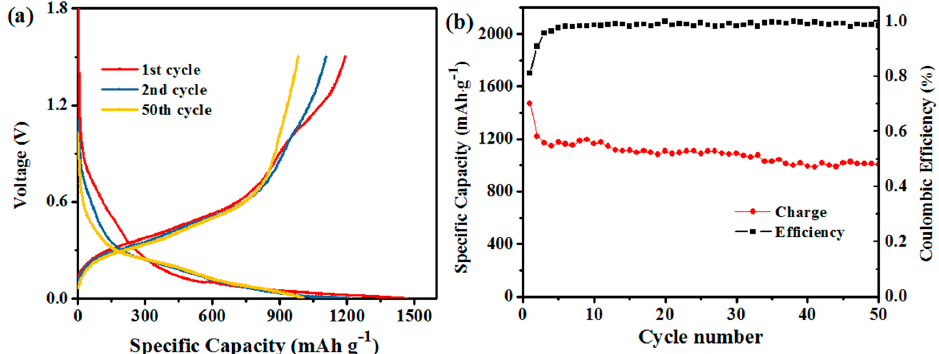
Figure 8. Charge / discharge profiles ( a ) and cycling performance ( b ) of the silicon-carbon nanocomposite Figure 8. Charge/discharge profiles ( a ) and cycling performance ( b ) of the silicon-carbon at 150 mA g − 1 between 0.01 and 1.5